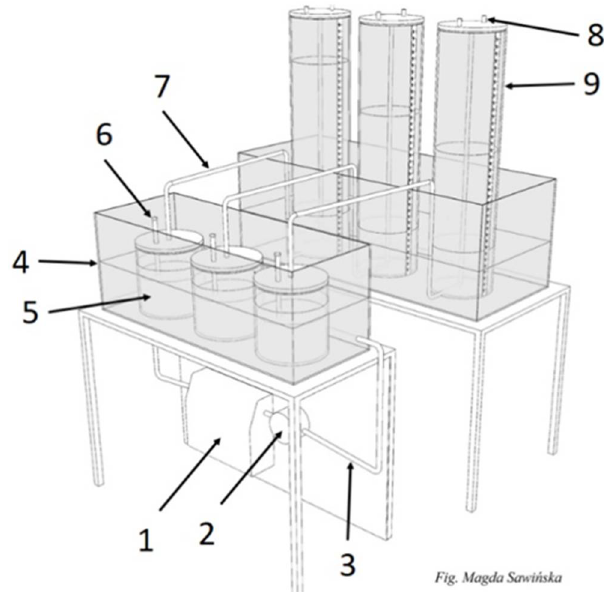
Figure 1. Scheme of a fermenter for biogas production research (3-chamber section): 1—water heater with temperature regulator, 2—water pump, 3—insulated conductors of calefaction liquid, 4—water coat, 5—fermenter with charge capacity 2 dm 3 , 6—sampling tubes, 7—biogas transporting tube, 8 - gas sampling valve, 9—biogas volume-scale reservoir [53].